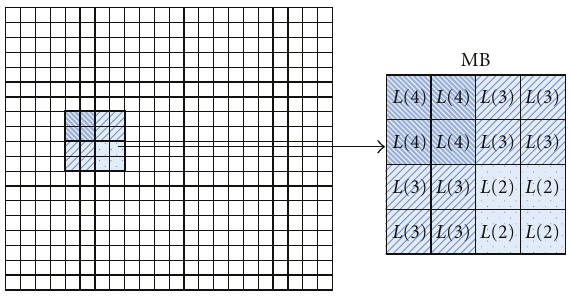
Figure 1: A example of MB partition information